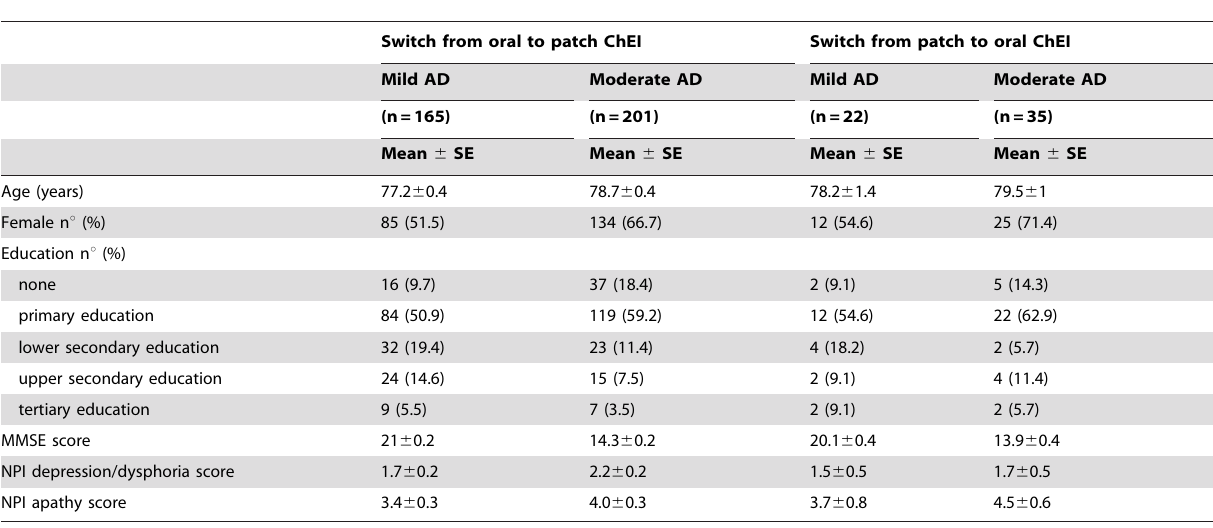
Table 1. Sociodemographic and clinical characteristics of the four switch subtypes.